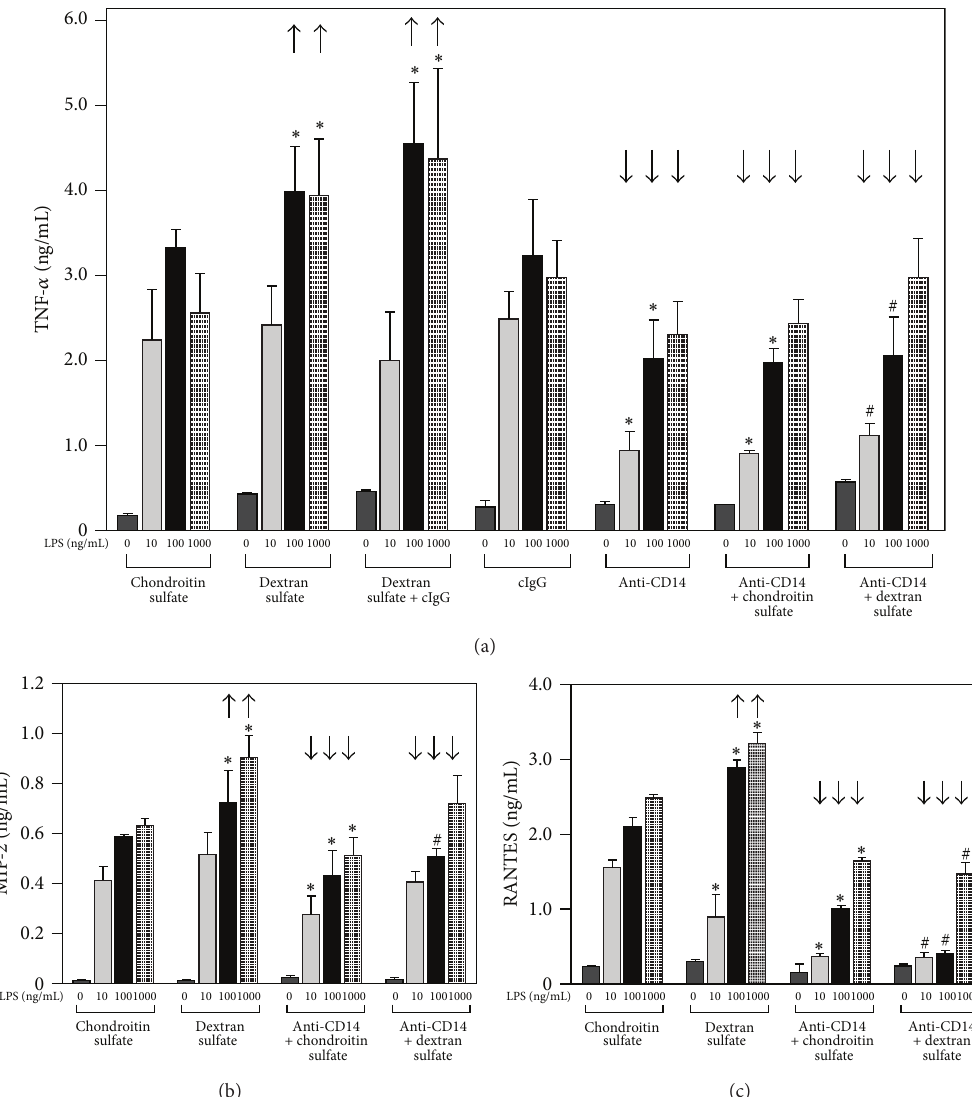
Figure 6: Occupation of SR by dextran sulfate upregulates sLPS-induced TNF- 𝛼 production with CD14 participation. RAW264 cells were pretreated with 50 𝜇 g/mL dextran sulfate or 50 𝜇 g/mL chondroitin sulfate or 10 𝜇 g/mL anti-CD14 or 10 𝜇 g/mL isotype-matched rat IgG2b (cIgG) or combination of the agents, as indicated, and subsequently were exposed to 10–1000ng/mL of sLPS (37 ∘ C). Generation of TNF- 𝛼 (a), MIP-2 (b), and RANTES (c) was estimated in culture supernatants by ELISA tests. Arrows directed upwards point to the enhancement of cytokine production stimulated by 100 or 1000 ng/mL of sLPS in the presence of dextran sulfate while arrows directed downwards indicate the inhibition of cytokine generation by the anti-CD14 in comparison to cells exposed to sLPS accompanied by dextran sulfate. Data shown are mean ± SEM from three or four experiments each run in triplicates. ∗ Significantly different from cells exposed to chondroitin sulfate and sLPS; # significantly different from cells exposed to dextran sulfate and